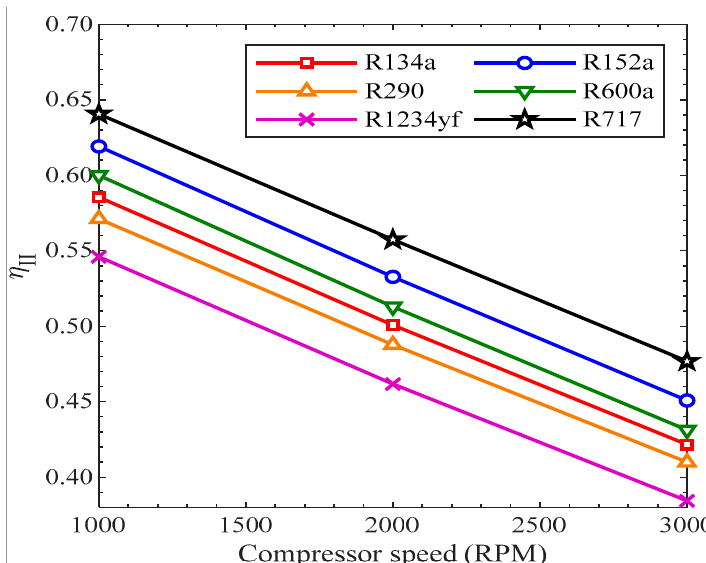
Figure 17 . Exergy efficiency vs. compressor speed .